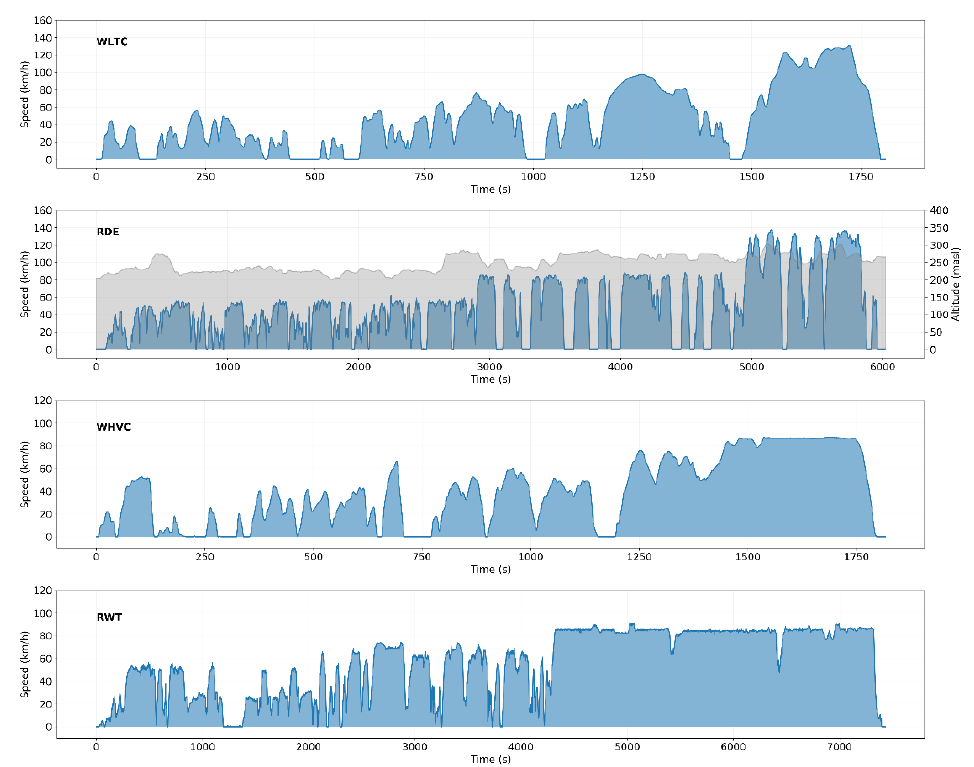
Figure 1. Speed profile of the different tests performed. Altitude profile is reported for the RDE test. The road load coefficients for the HDV were estimated to be F0 = 1460 N and F2 = 0.247 N/(km/h) 2 for inertia of 29,000 kg, corresponding to ~59% of maximum